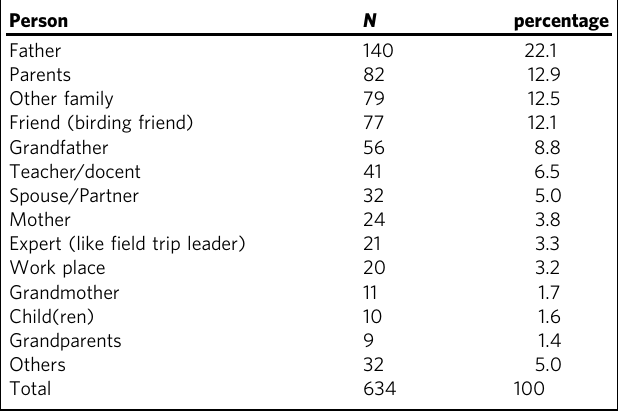
Table 2 Initial involvement by a person ranked by importance (except category other, placed at the end).